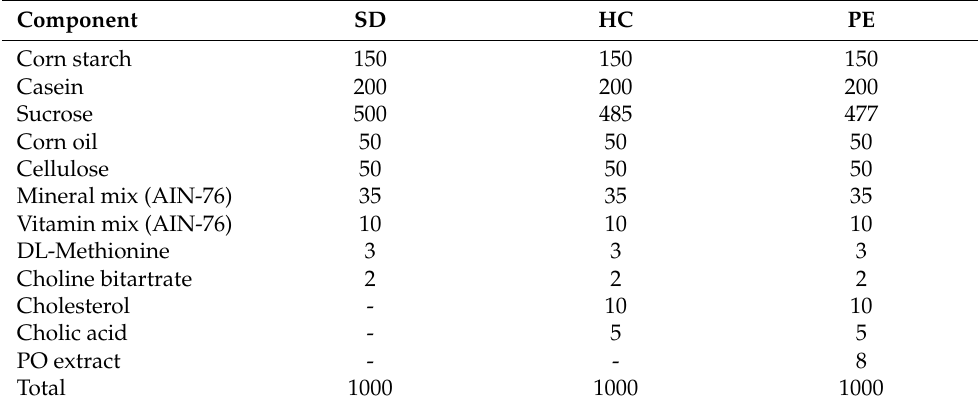
Table 1. Composition of experimental diets